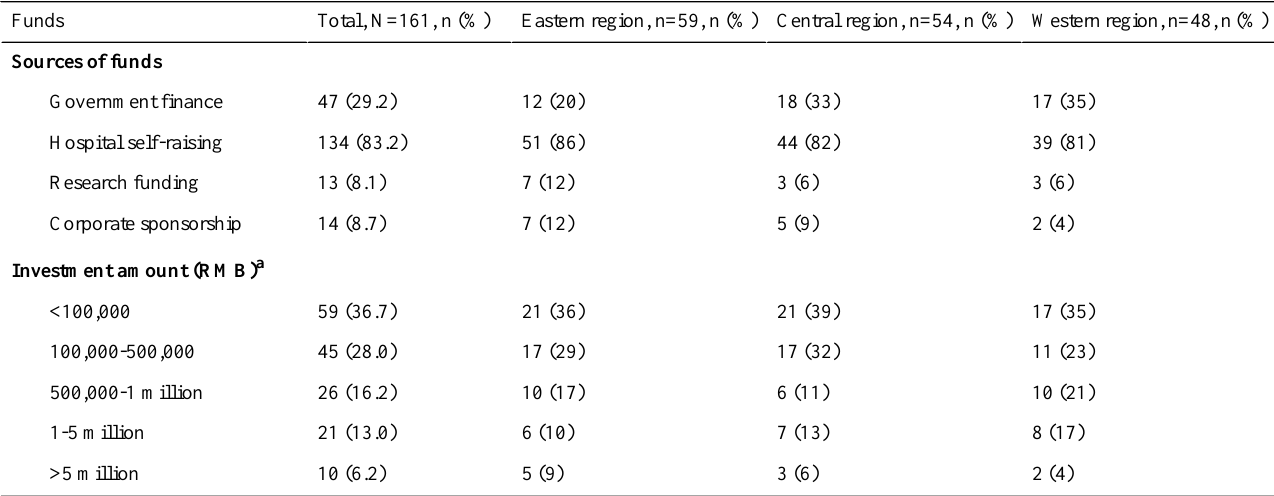
Table 2. Source and investment amount of telemedicine implementation in tertiary hospitals in different regions of China (N=161).